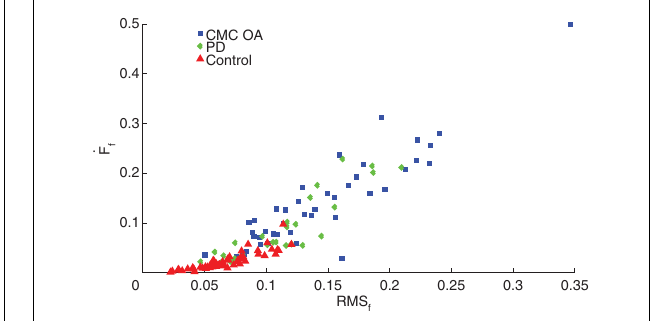
FIGURE 4 | Dynamic characteristics of the SD test . Control participants (red triangles) had significantly greater stability during SD compression compared to patients with CMC OA (blue squares) and PD (green